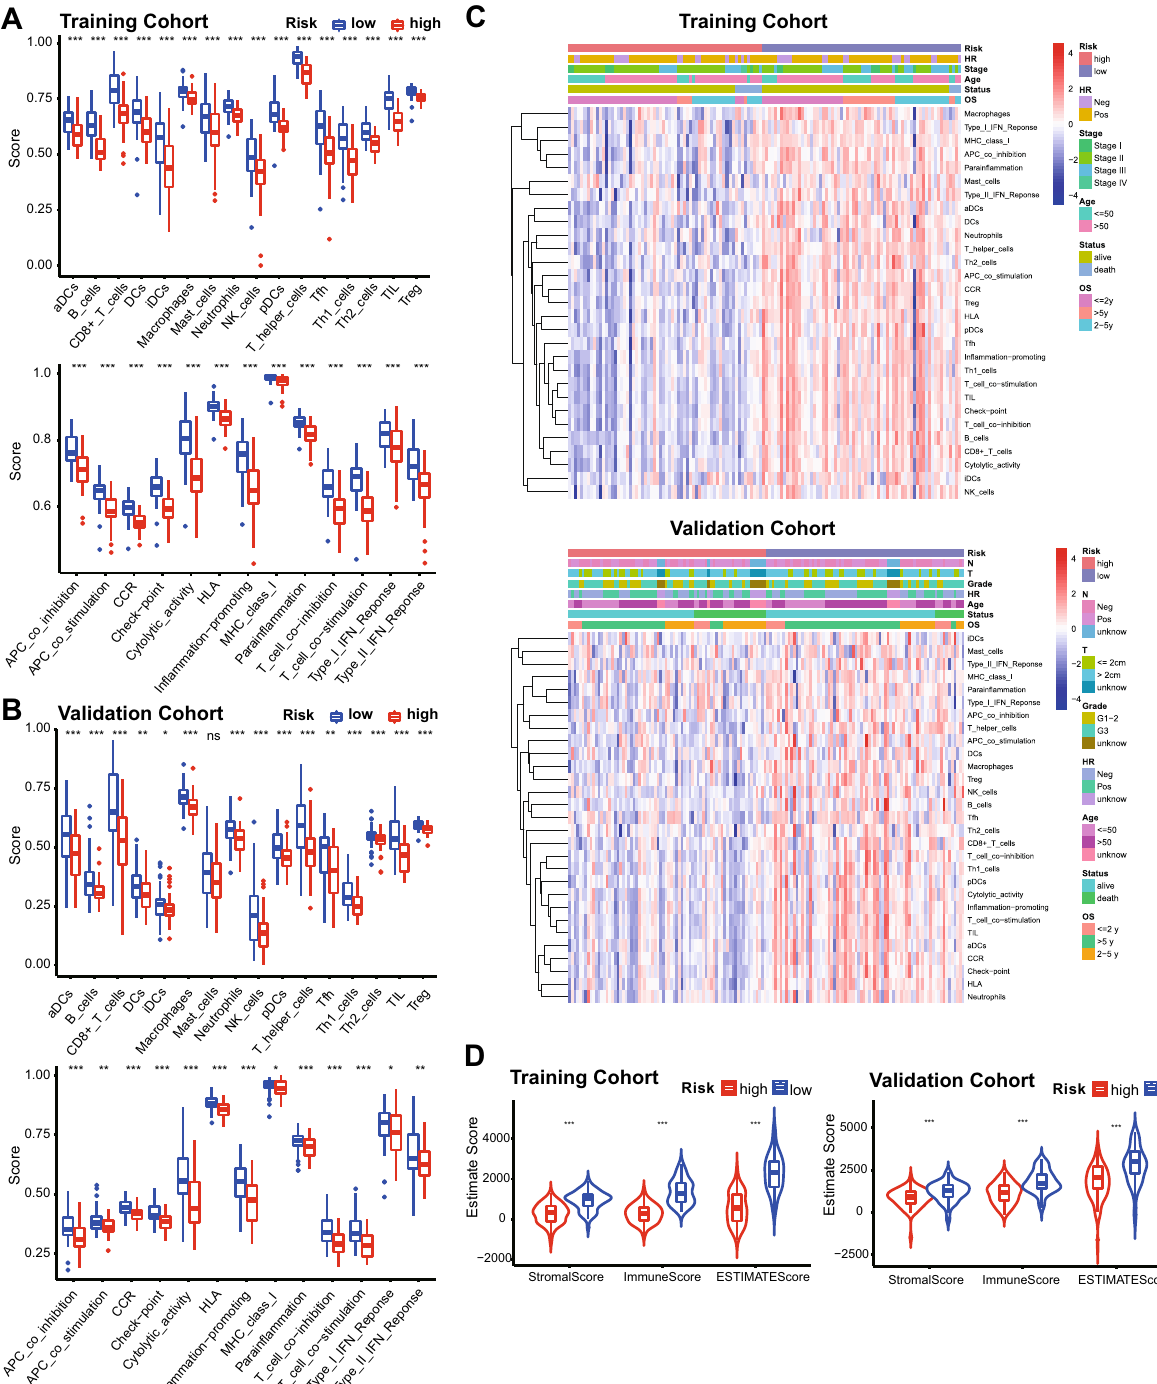
Figure 4. Tumor immune landscape in the high-risk score group and low-risk score group. ( A ) Immune infiltration (top) and immune function (bottom) in the training cohort. ( B ) Immune infiltration (top) and immune function (bottom) in the validation cohort. ( C ) Unsupervised clustering heat map showing the association between immune infiltration and survival-related clinical characteristic parameters, including risk score, age, hormone receptor status, histology grade, tumor stage, OS and survival status, in the training cohort (top) and validation cohort (bottom). ( D ) Comparison of the Estimate scores between the high-risk score group and the low-risk score group in the training cohort and validation